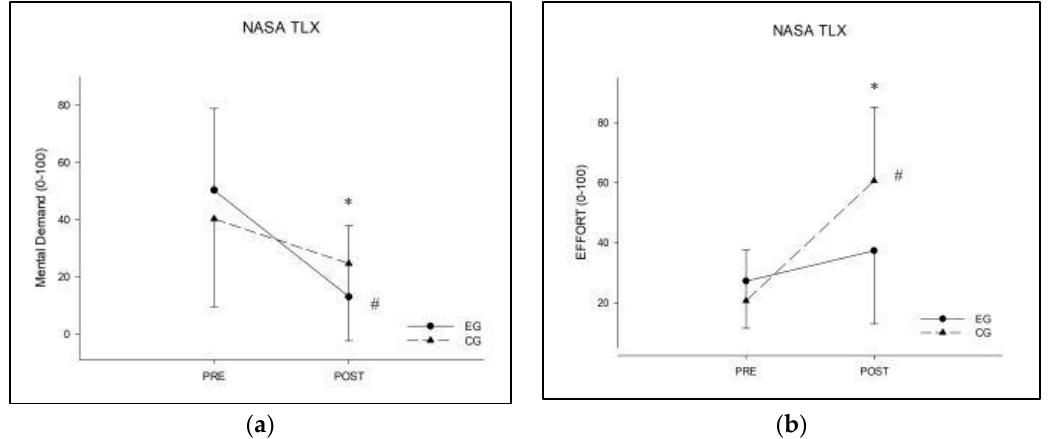
Figure 3. NASA-TLX analysis in the pre and post phases. ( a ) Analysis of effort; ( b ) analysis of mental demand. * = significant p -value (<0.05) in between groups analysis (EG vs. CG); # = significant p -value (<0.05) in within group analysis (pre vs. post). Table 3. Results of the NASA-TLX and SF-12 questionnaires performed before the intervention (pre) and at the end of the intervention (post).